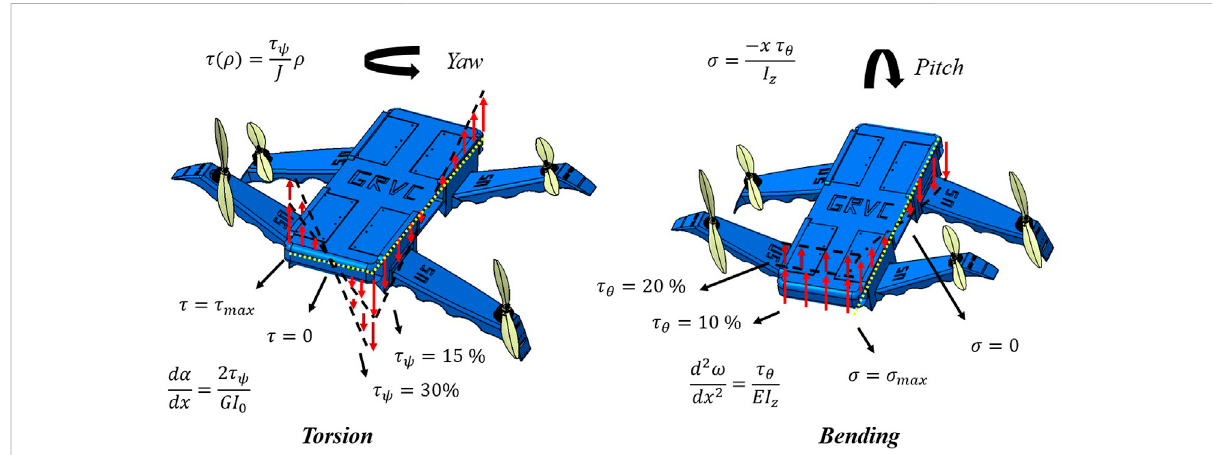
FIGURE 5 The left Figure shows the evolution of the torsion angle obtained analytically (dots) and experimentally (triangles) as a function of the in fi ll rate fl ections produced by material degradation as a function of the number of cycles N ρ tpu . The right Figure analyzes arm de line corresponds to the standard deviation σ of the experiments, while the limiting angle for fi bers rupture corresponds to the black dashed line.